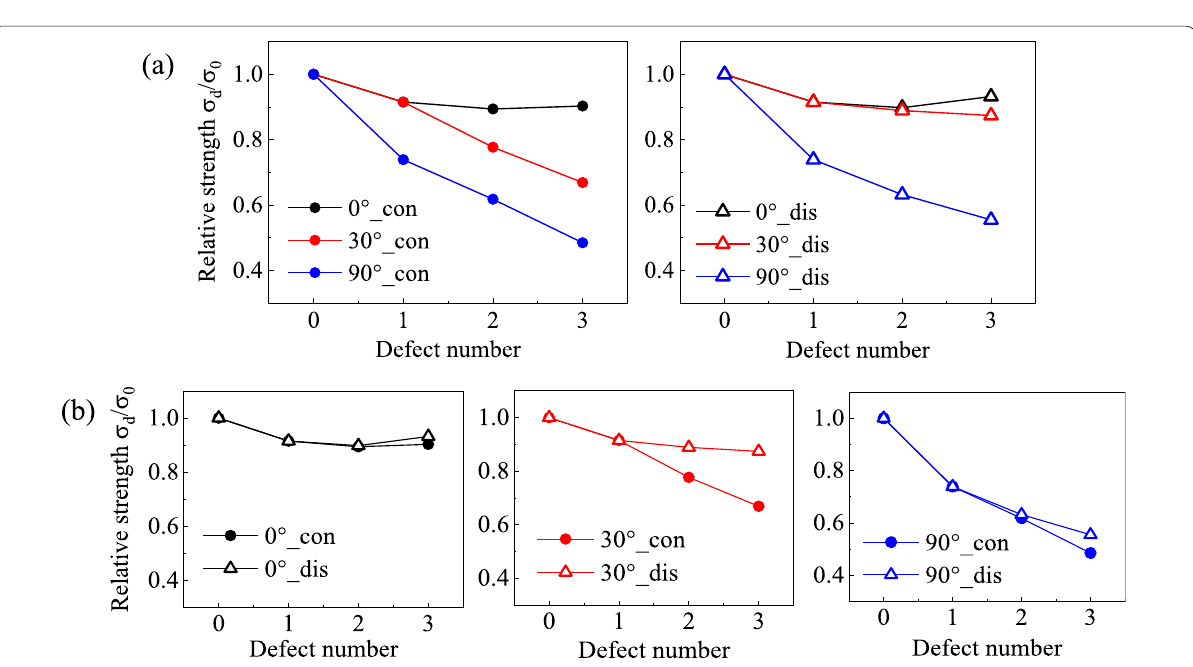
Fig. 4 Variation of relative tensile strengths of defective zigzag SCNTs versus defect number. a Comparisons between different distribution orientations; b Comparisons between different distribution